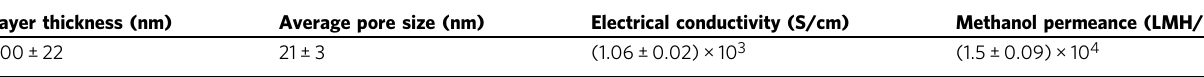
Table 1 Properties of the PDA-CNT porous